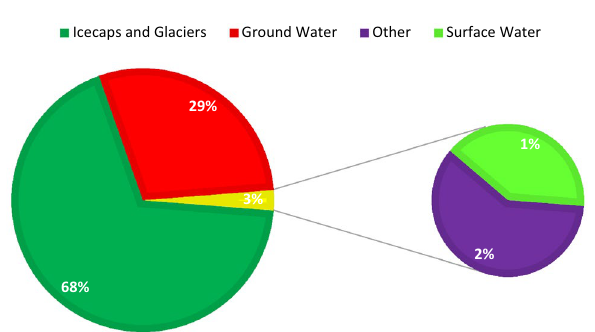
Fig. 2 Percentage of freshwater sources